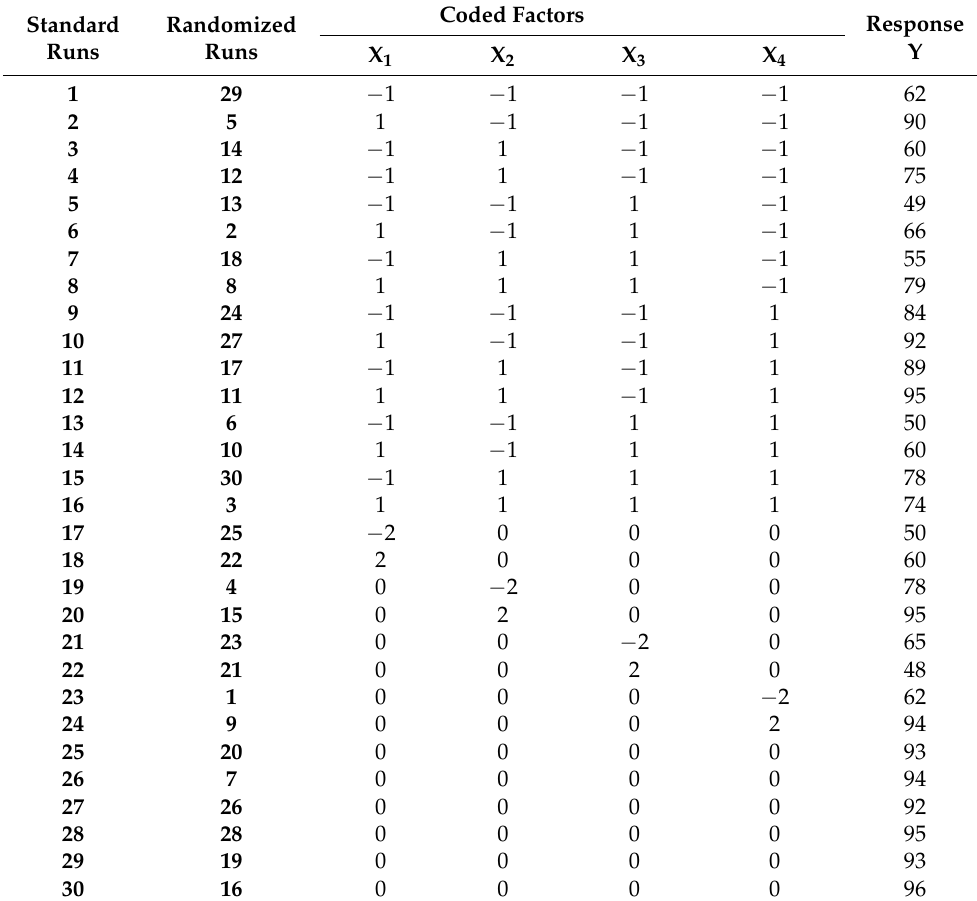
Table 4. ANOVA for Response Surface Quadratic